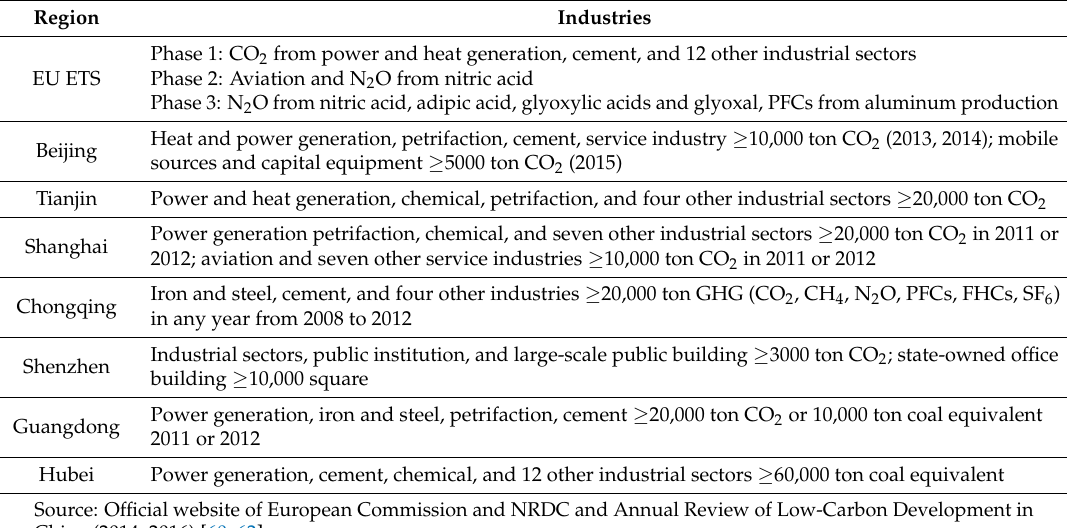
Table 5. Industries included in EU ETS and China’s pilot